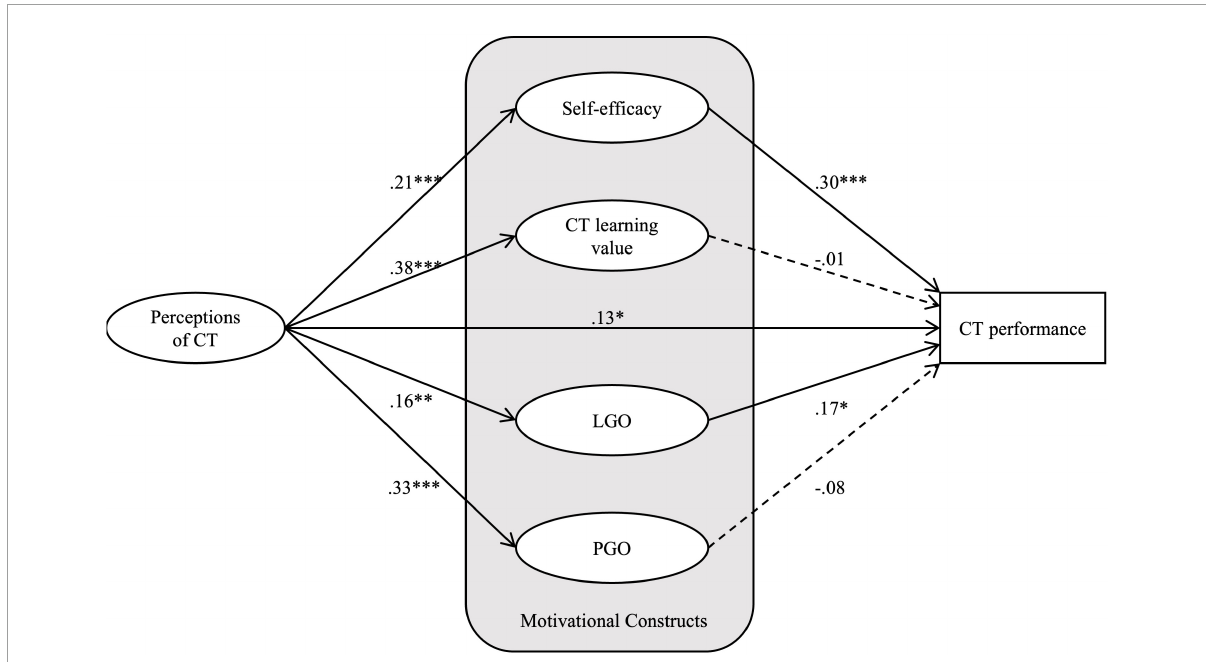
FIGURE3 Structural model and standardized path coefficients. ∗ p < 0.05, ∗∗ p < 0.01, ∗∗∗ p < 0.001; dashed lines indicate non-significant paths.